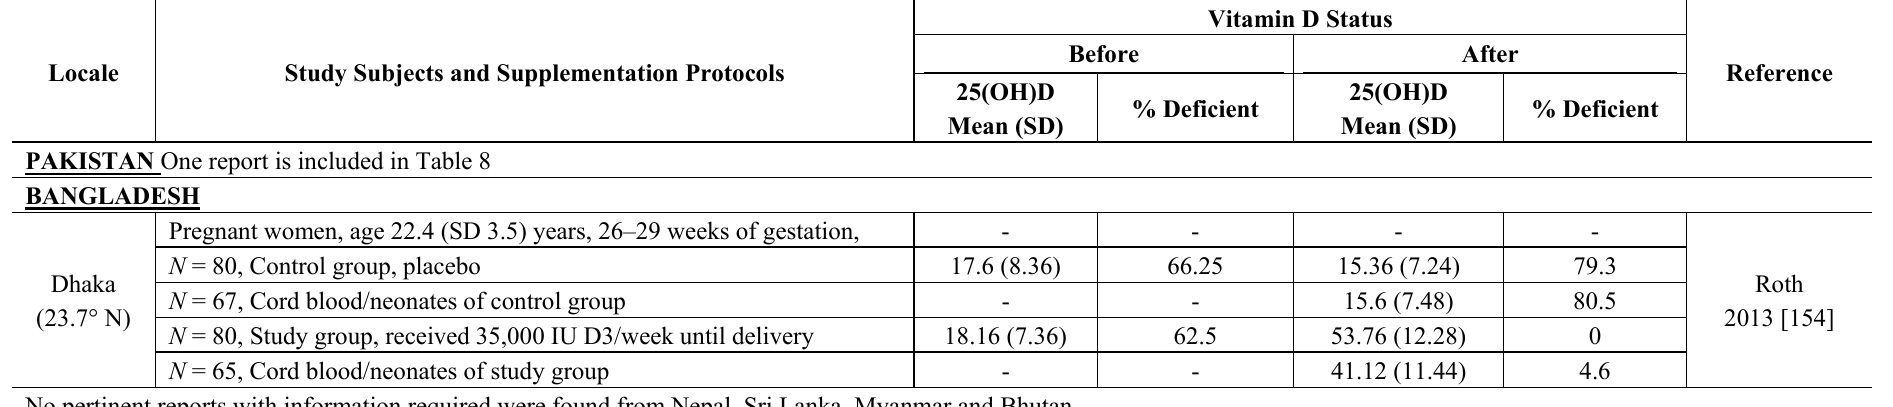
Table 7. Vitamin D supplementation studies in ostensibly healthy subjects from other countries of the Indian subcontinent. All 25(OH)D values have been shown in ng/mL. To convert from nM to ng/mL, nM values were divided by (2.5). Vitamin D deficiency is defined as 25(OH)D < 20 ng/mL, insufficiency as 20–29 ng/mL and sufficiency as ≥ 30 ng/mL. D3 is cholecalciferol.